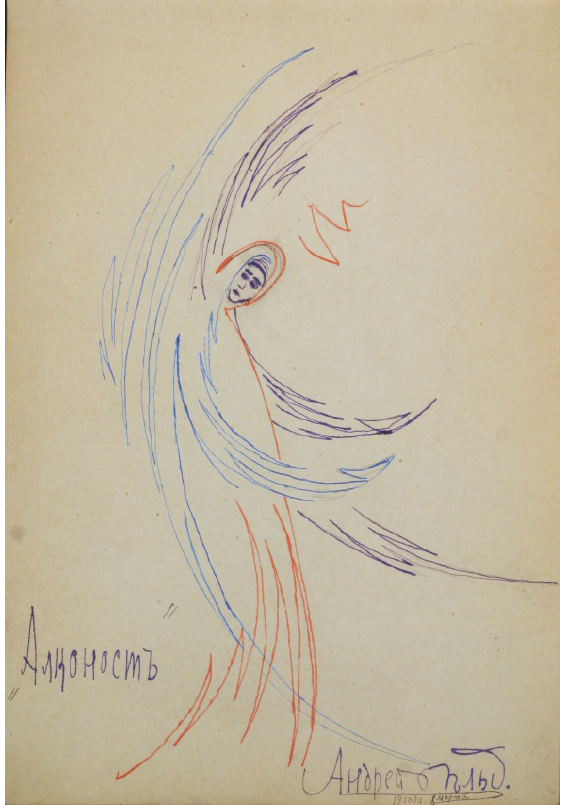
Figure 14. Andrei Bely. Alkonost. Drawing from S.Y. Alyanski’s album. 1919. The State Museum-Reserve D.I. Mendeleev and A.A. Blok.